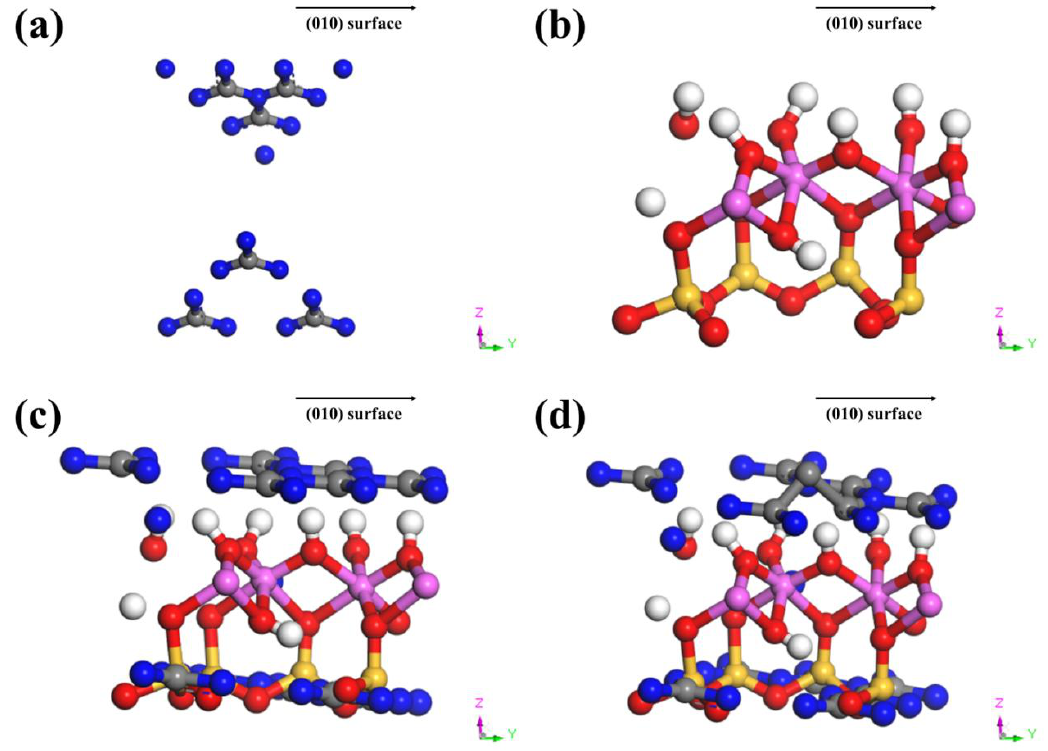
Figure 6. Side view of the basal (010) surfaces of ( a ) CN (C 6 N 21 ), ( b ) KA (H 8 Si 4 Al 4 O 18 ), ( c ) CN/KA (2C 6 N 15 -H 8 Si 4 Al 4 O 18 ), and ( d ) m-CN/KA (2C 7 N 14 -H 8 Si 4 Al 4 O 18 ). Color scheme (used for all figures): hydrogen, white; oxygen, red; aluminum, pink; silicon, yellow; carbon, gray; nitrogen, blue.